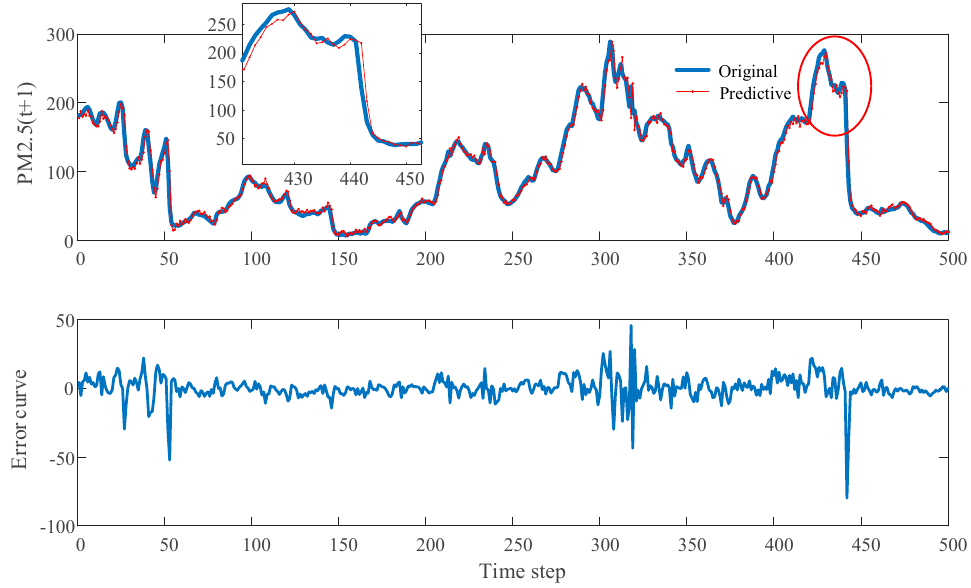
Figure 5. PM 2.5 concentration one-step (1 hour) prediction curve.